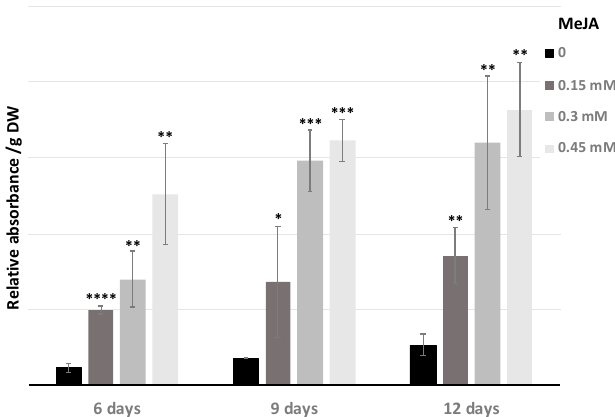
Figure 4. Stacked HPLC chromatograms of methanolic extracts obtained from hairy root elicitated (pink line) and not elicitated (dark line). ( 1 ) caffeoylquinic acid (5-CQA); ( 2 ) 3,5-dicaffeoyquinic acid (di-CQA); ( 3 ) 3,4,5-tricaffeoylquinic acid (tri-CQA).